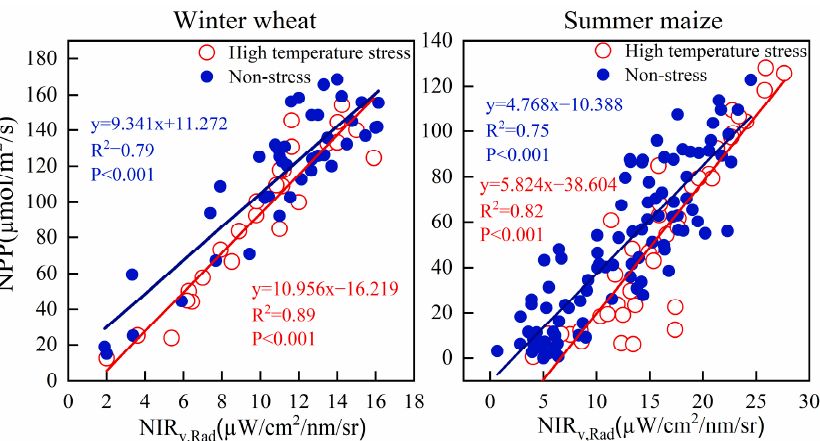
Figure 9. Scatter plots of NIR v,Rad -NPP correlations at hourly scales for winter wheat (C3) and sum- mer maize (C4) under high-temperature stress and non-stress conditions, coefficient of determination (R 2 ), red solid lines indicate fitted curves of NIR v,Rad -NPP under high light stress, blue solid lines indicate fitted curves of NIR v,Rad -NPP under non-light stress .